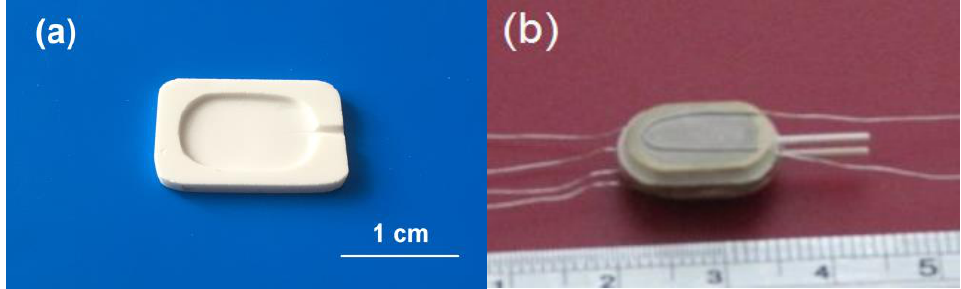
Figure 1. Photo of ( a ) YSZ plate with a cavity and a groove for a capillary, ( b ) an image of the manufactured sensor.